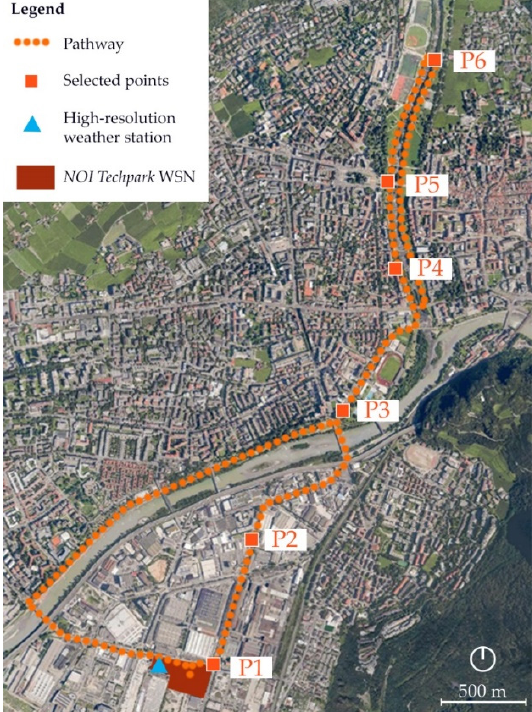
Figure 6. Selected pathway for the mobile monitoring campaigns. Aerial image source: [39].